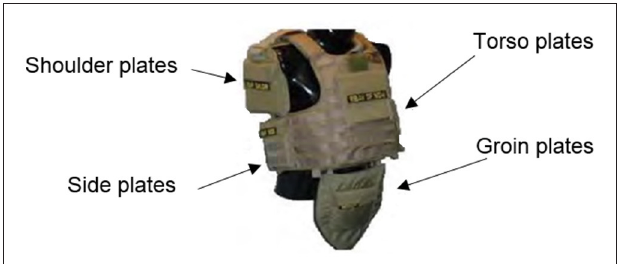
FIGURE 1 | Releasable body armor vest (with permission Cavallaro, 2011).